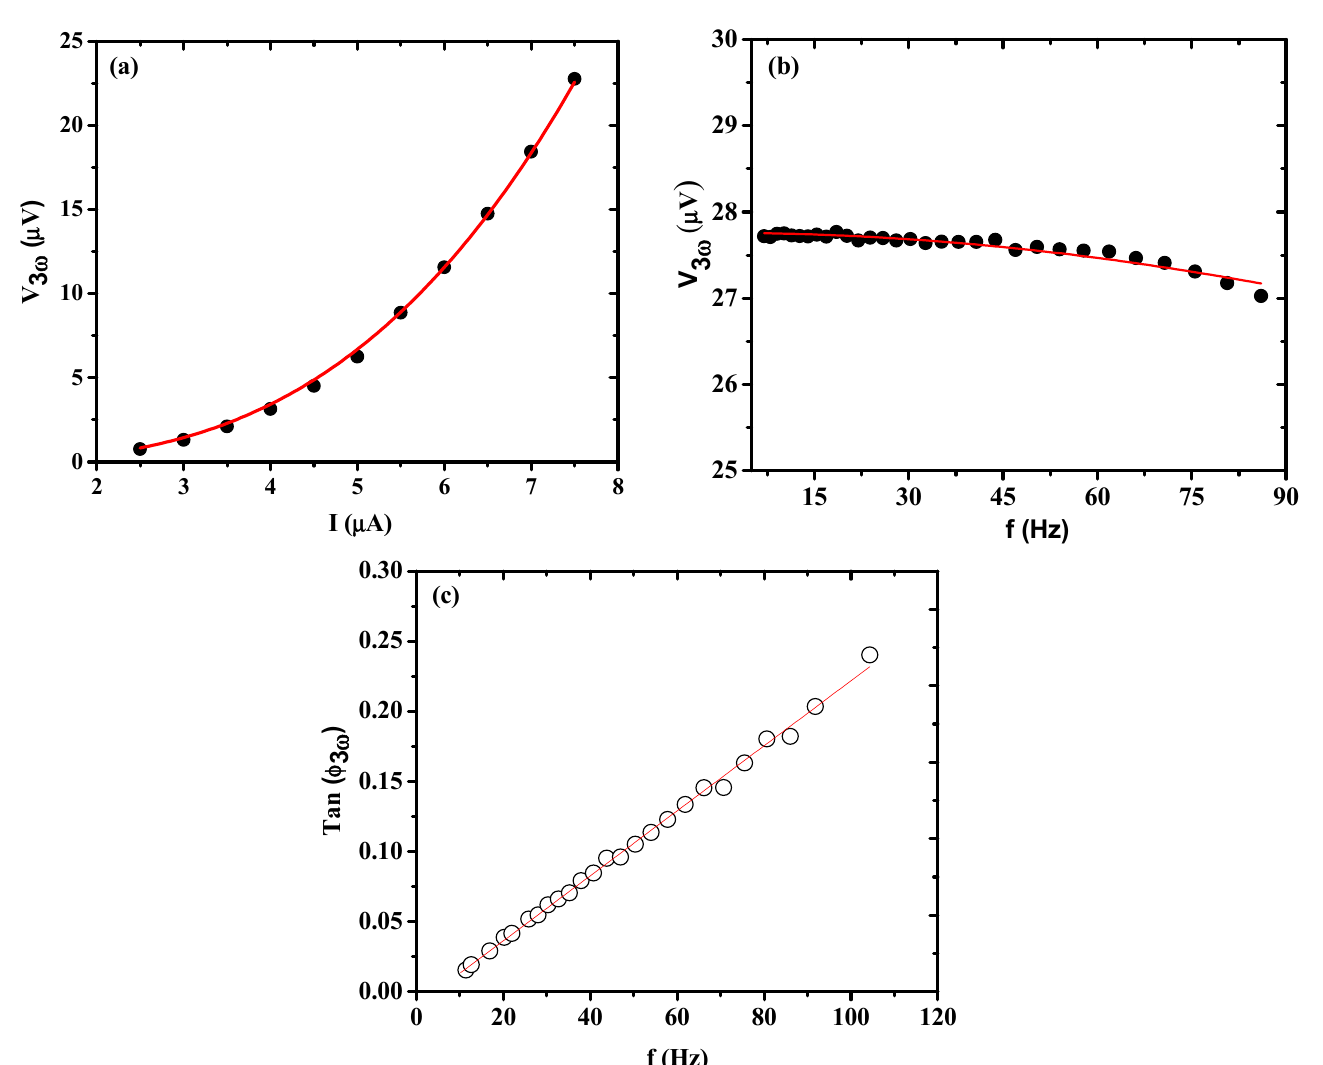
Figure 5. ( a ) The third harmonic voltage signal V3 ω as function of the extraction current amplitude I o . The solid line shows the cubic relationship of V3 ω and I o . ( b ) Frequency dependence of V3 ω . The solid line is the predicted relation V 3 ω α 1/ 1 + ( 2 ωγ ) 2 . ( c ) The frequency dependence of the phase angle of V3 ω at 300 K of Bi 2 Se 3 NW; d = 200